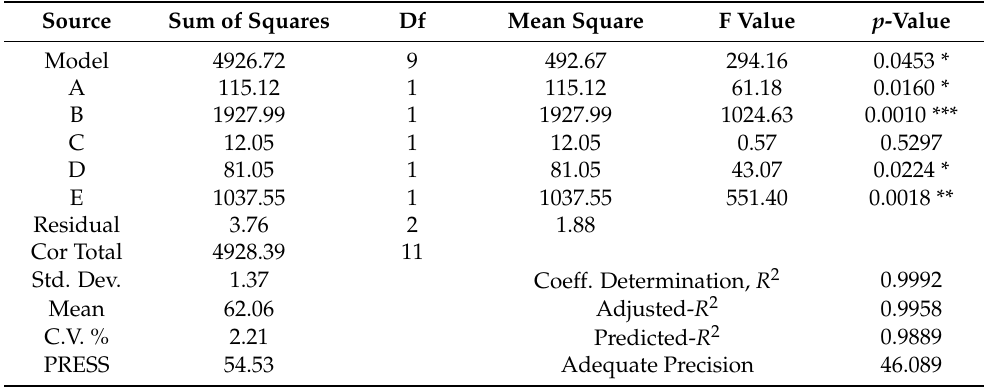
Table 3. Analysis of variance of TPH degradation by consortium BS24 in PBD analysis. Source Sum of